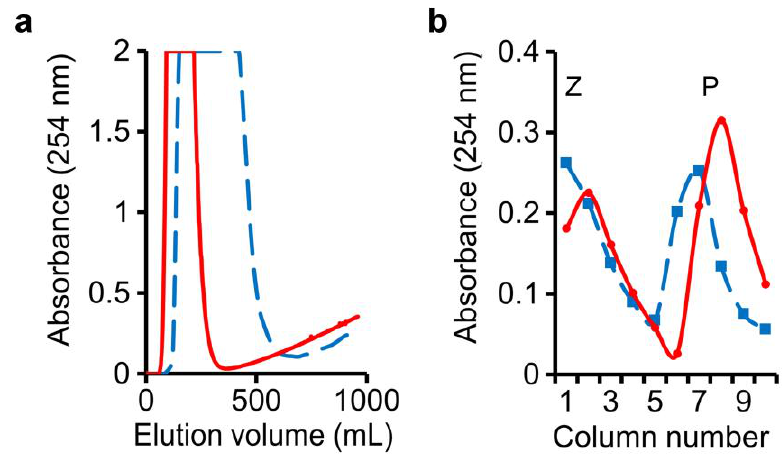
Figure 3. Separation of benzyl alcohol, phenol, and benzoic acid: ( a ) Benzyl alcohol peak was followed by initial appearance of phenol in mobile-phase eluate; ( b ) Benzoic acid (Z) and phenol (P) in stationary phases drained from individual separation columns. Solid line: regular setup; dashed line: high dead-volume setup.